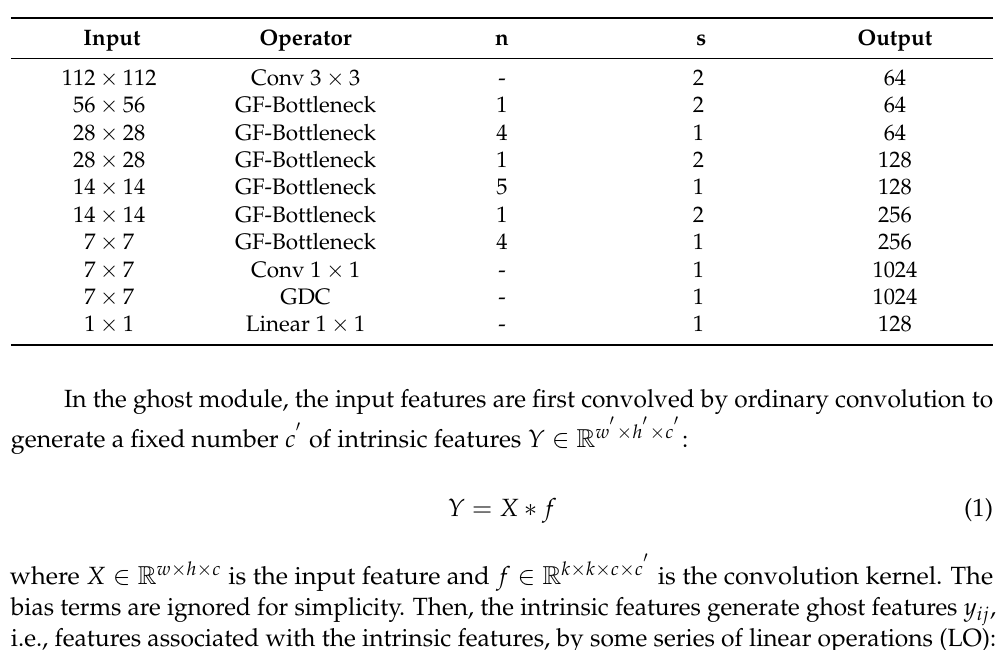
Table 1. The overall framework of GhostFaceNet. n represents the number of module rereads, and s indicates the number of similar features generated by each intrinsic feature.